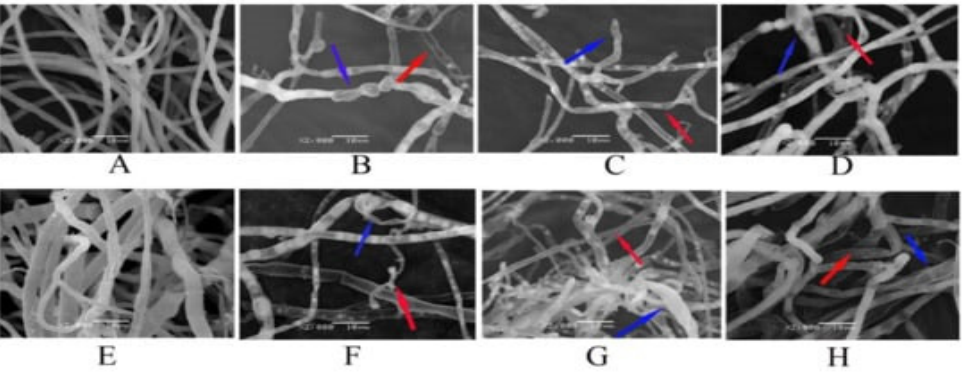
Figure 6. SEM images of the structural changes in the morphology of F. graminearum induced by fungicides, GO–fungicides and GO. Mycelia of the control ( A ), GO–treated (( E ), 100 µ g/mL − 1 ), Man–treated (( B ), 20 µ g mL − 1 ), Man–GO–treated (( F ), 20 µ g mL − 1 ), Cyp–treated (( C ), 100 µ g mL − 1 ), Cyp–GO–treated (( G ), 100 µ g mL − 1 ), Dif–treated (( D ), 200 µ g mL − 1 ) and Dif– GO–treated (( H ), 200 µ g mL − 1 ) F. graminearum , respectively. The position marked by a red arrow indicates hollowness, and that marked by a blue arrow indicates swelling